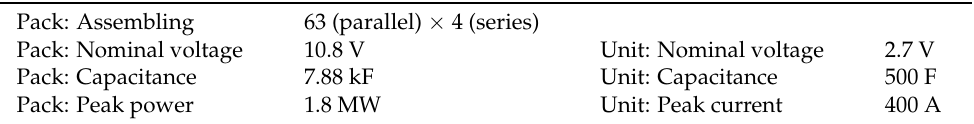
Table 7. Hypothetical Supercapacitor Bank (not modeled).